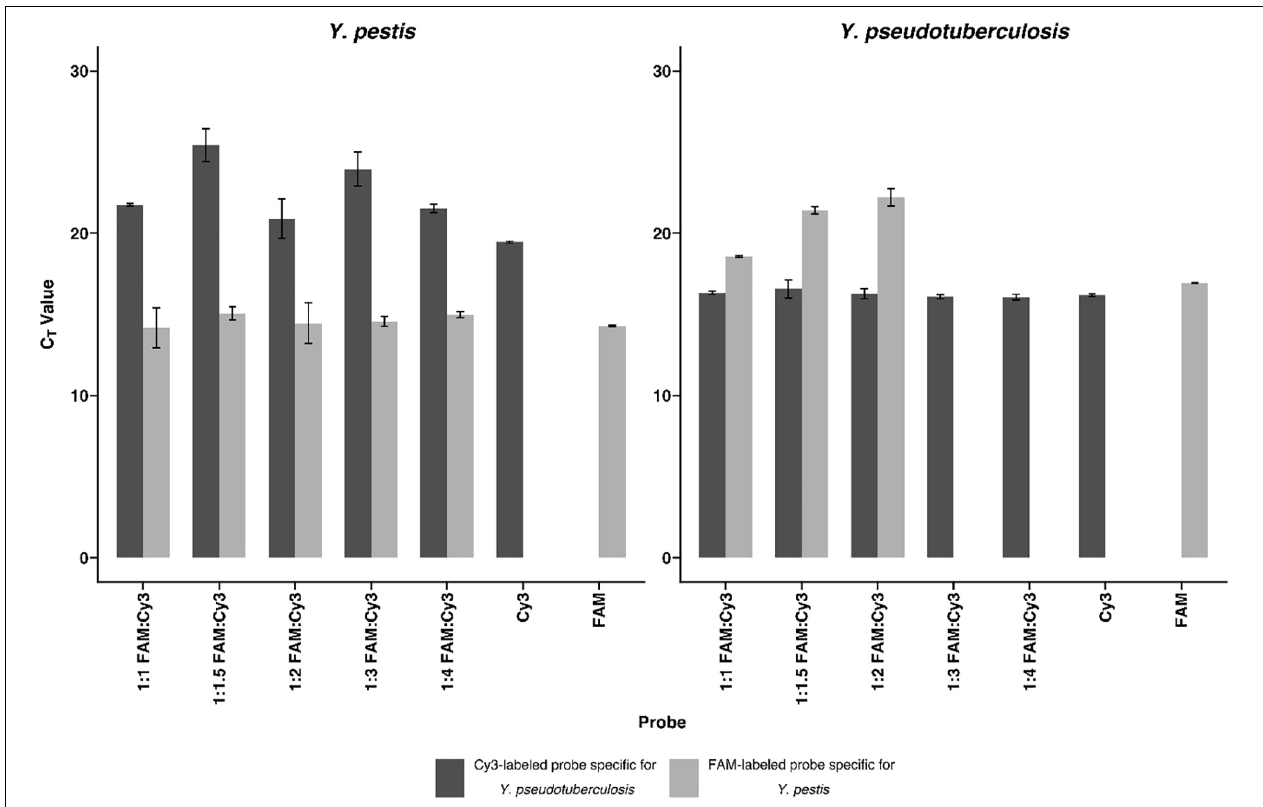
FIGURE 1 | Competitive probe detecting Yersinia pseudotuberculosis in comparison with the probe detecting Yersinia pestis . To show the effectiveness of the competitive probe, both probes were tested separately and in different ratios of the probes for Y. pestis and Y. pseudotuberculosis . DNA (0.5 ng/ µ l) isolated from both bacteria were subjected to rtPCR. The competitive probe is labeled with Cyanine 3 (Cy3), whereas the Y. pestis specific probe is labeled with carboxyfluorescein (FAM). The detection of Y. pestis is not notably influenced by the addition of the competitive probe. Y. pseudotuberculosis is undetectable in the FAM channel using a ratio of 1:3 Y. pestis specific probe: Y. pseudotuberculosis specific probe or higher. Error bars represent the SD of three independent replicates.